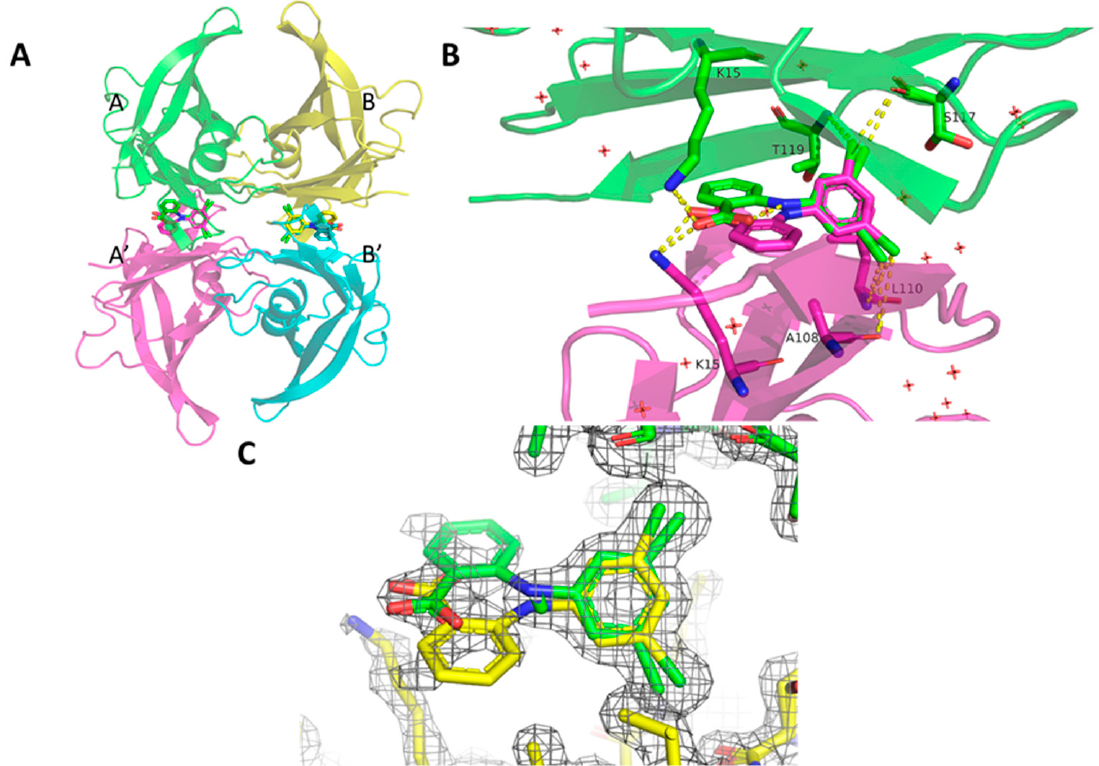
Figure 3. A. The binding mode of VCP-6 (sticks) in the ( A )-A ′ (green and magenta) and ( B )-B’ (yellow and cyan) binding pockets of the hTTR. VCP-6 binds in the forward binding mode. Note the two alternative positions of the VCP-6 anthranilic acid ring which is supported by the simulated composite omit maps (2fo-fc) maps contoured to 1.3 σ shown in panel ( C ). B. Interactions of VCP-6 in the A-A’ dimer. Highlighted via sticks and labelled are the amino acids which directly interact with VCP-6 either via a hydrogen bond (Lys15) or halogen bonds (A108, L110, S117 and T119). The intramolecular hydrogen bond is also shown with yellow dashed lines.